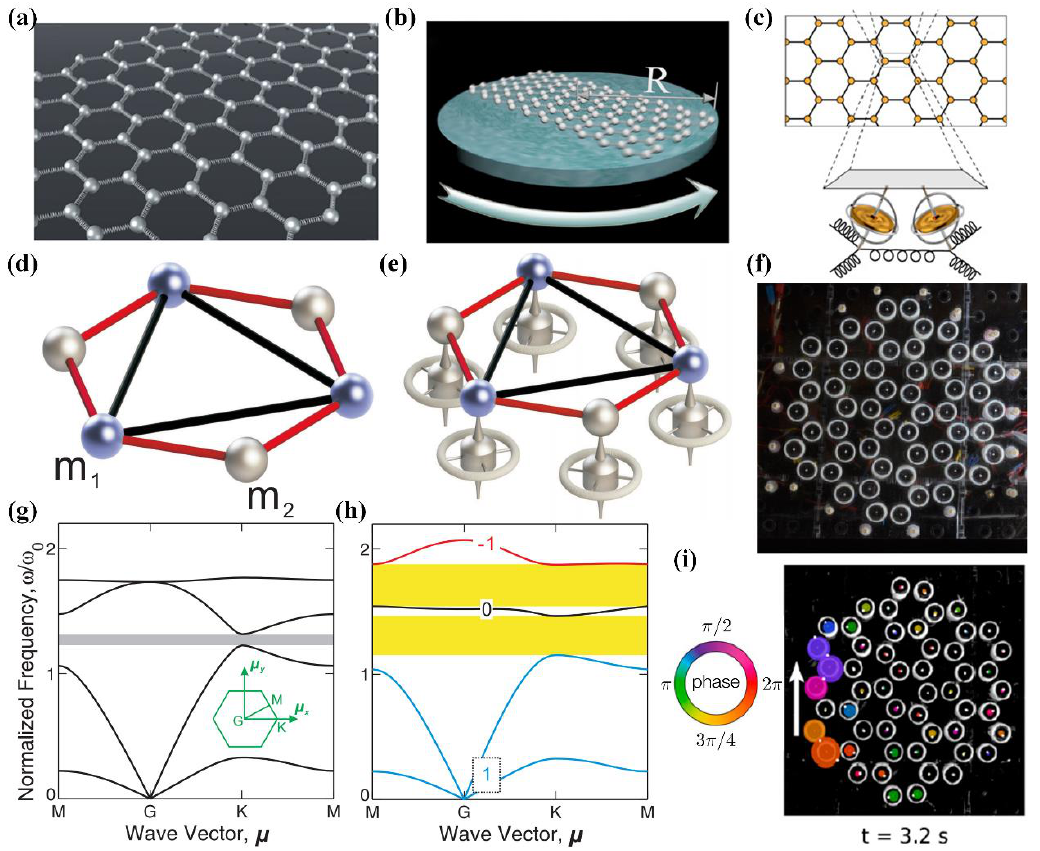
Figure 1. Analogue Hall insulators . ( a ) The mass-spring system is arranged in honeycomb lattices [54]. ( b ) The non-inertial system [54]. ( c ) The hexagonal gyroscopic lattice [57]. ( d ) The ordinary (nongyroscopic) unit cell [56]. ( e ) The gyroscopic unit cell [56]. ( f ) The experimental system [57]. ( g ) The dispersion of the ordinary (nongyroscopic) phononic crystal [56]. ( h ) The dispersion of the gyroscopic phononic crystal with the Chern numbers labeled on the bulk bands [56]. ( i ) One period of the unidirectional waveguide mode at t = 3.2 s , the ellipses denote the shape of each orbit, and the colors denote the phase at a fixed time